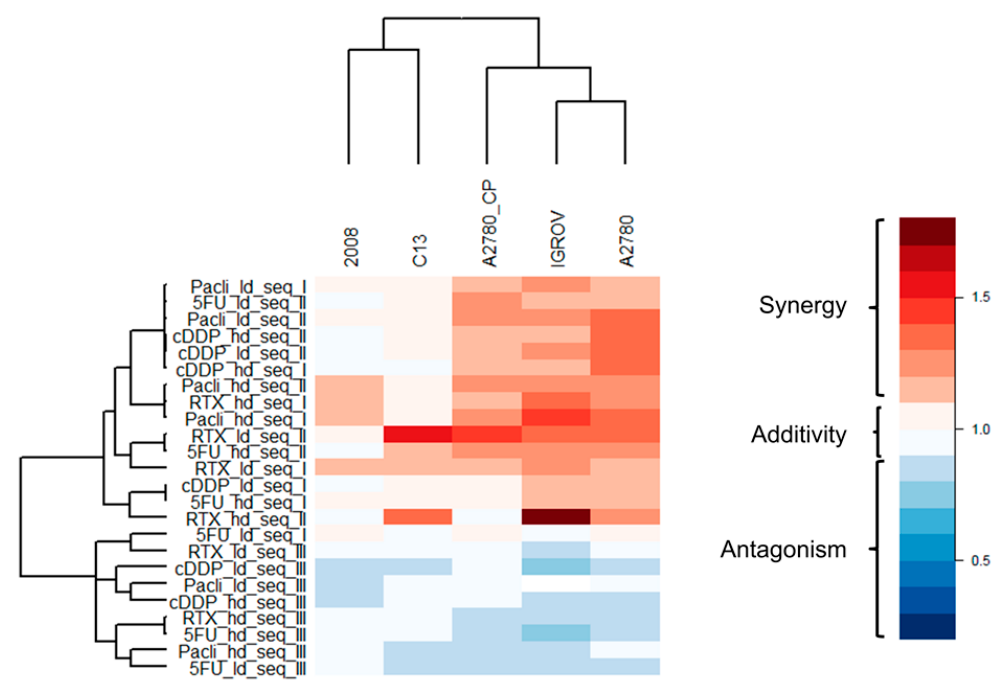
Figure 4. Heatmap of the synergism quotient values of the tested combinations (rows) against the different cell lines (columns). Colour code: red, SQ > 1; blue, SQ < 1. The reported dendrogram was built based on the dissimilarity matrix using Euclidean distances and the complete linkage method. ld: lower dose; hd: higher dose; Pacli: paclitaxel, Seq I, II, III: combination sequences I, II and III as described in the text.